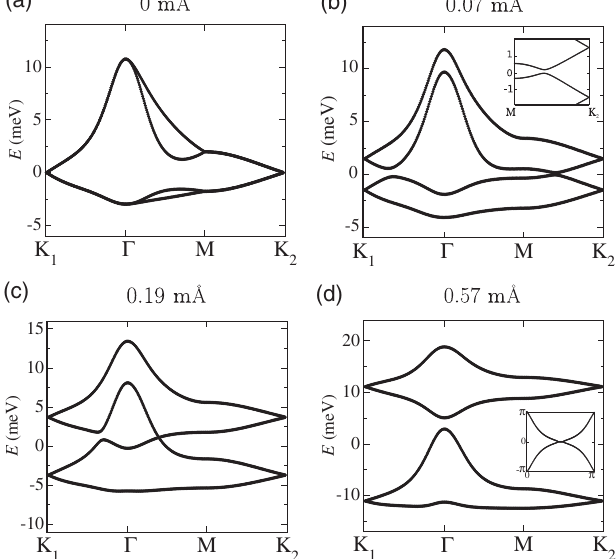
VIDEO 1. Evolution of the FBs when the lattice is distorted with increasing intensity along one of the two modes indicated by a red arrow in Fig. 5. (a) Undistorted. (b) Mean displacement per atom 0.07 mÅ. In the inset we show the avoided crossing along M → K 2 . (c) Mean displacement 0.19 mÅ. Now the avoided crossing appears as a genuine crossing protected by C 2 sym- x metry along Γ → M , which actually leads to Dirac points. (d) Mean displacement 0.57 mÅ, opening a gap between the FBs. Inset: Wilson loop of the lowest two bands in